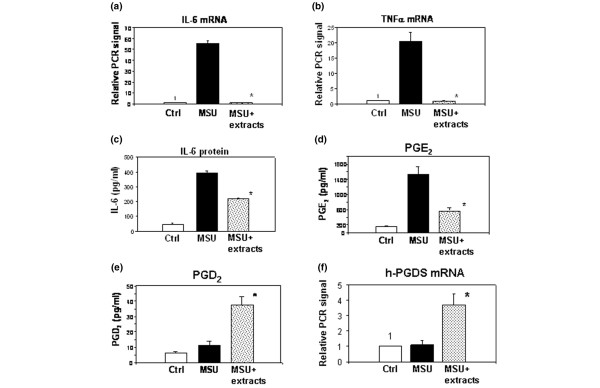
Treatment with the root extracts reduces expression of pro-inflammatory factors and raises PGD2 levels. (a) and (b) represent the averages of two experiments with four mice in each group, (c–e) show the results from a separate experiment with seven mice per group, and (f) shows the results from an experiment with five mice per group. The effect of the root extracts on the leukocyte density in the exudate was nearly identical in both experiments. (a) Pouch membrane IL-6 mRNA. Real-time RT-PCR, normalized to GAPDH, as outlined in the Methods and Materials section. The control group was assigned the relative expression level of 1. The numerical values (± standard error of the mean) were as follows: MSU, 55.47 ± 2.68; and MSU + extracts, 0.56 ± 0.12. (b) Pouch membrane TNF-α mRNA. Analysis was identical to (a): Ctrl, 1; MSU, 20.43 ± 2.91; and MSU + extracts, 0.81 ± 0.09. (c) IL-6 protein levels in the pouch exudate (ELISA, pg/ml): Ctrl, 44.75 ± 1.34; MSU, 391.54 ± 16.77; and MSU + extracts, 217.99 ± 7.26. (d) PGE2 levels in the pouch exudate (ELISA, pg/ml): Ctrl, 150.06 ± 20.84; MSU, 1530.49 ± 205.93; and MSU + extracts, 572.93 ± 72.88. (e) PGD2 levels in the pouch exudate (ELISA, pg/ml): Ctrl, 5.98 ± 0.48; MSU, 11.02 ± 2.49; and MSU + extracts, 37.34 ± 5.77. PGD2:PGE2 ratios were as follows: Ctrl, 0.040; MSU, 0.007; and MSU + extracts, 0.065. (f) Pouch membrane h-PGDS mRNA. Analysis was identical to (a). The numerical values were as follows: Ctrl, 1; MSU, 1.1 ± 0.28; and MSU + extracts, 3.72 ± 0.68. *, p < 0.05 compared with MSU. Ctrl, control; ELISA, enzyme-linked immunosorbent assay; GAPDH, glyceraldehyde 3-phosphate dehydrogenase; h-PGDS, hematopoietic prostaglandin D synthase; IL, interleukin; MSU, monosodium urate; PGD2, prostaglandin D2; PGE2, prostaglandin E2; RT-PCR, reverse transcriptase polymerase chain reaction; TNF, tumor necrosis factor.